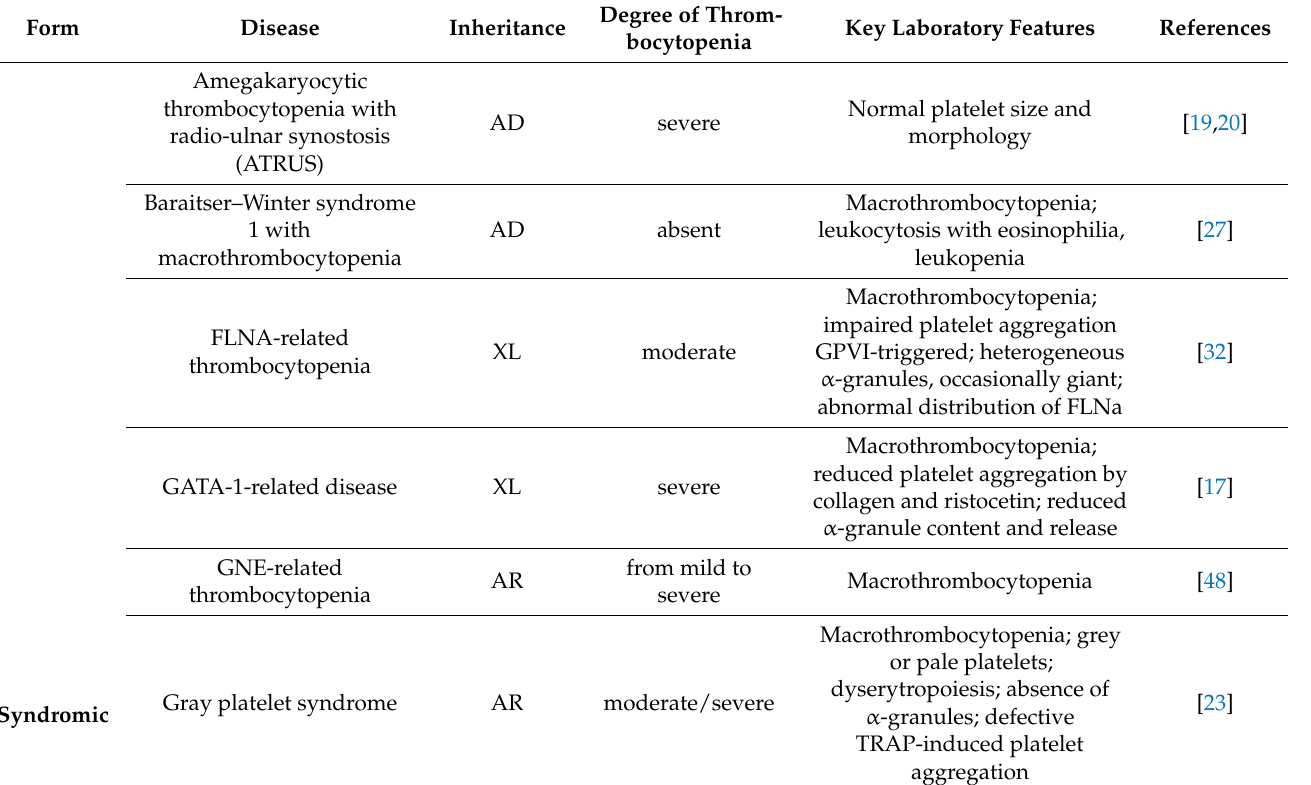
Table 3. Main features of inherited